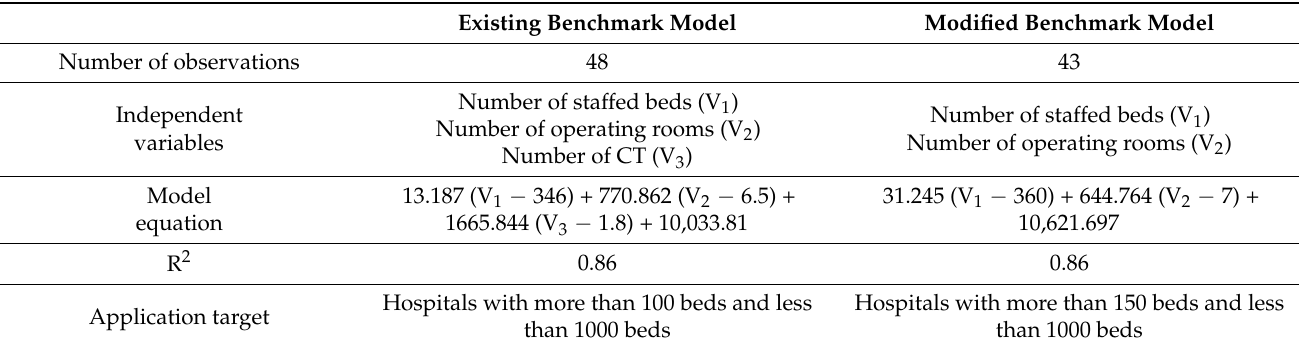
Table 13. Comparison of existing benchmark model and modified benchmark